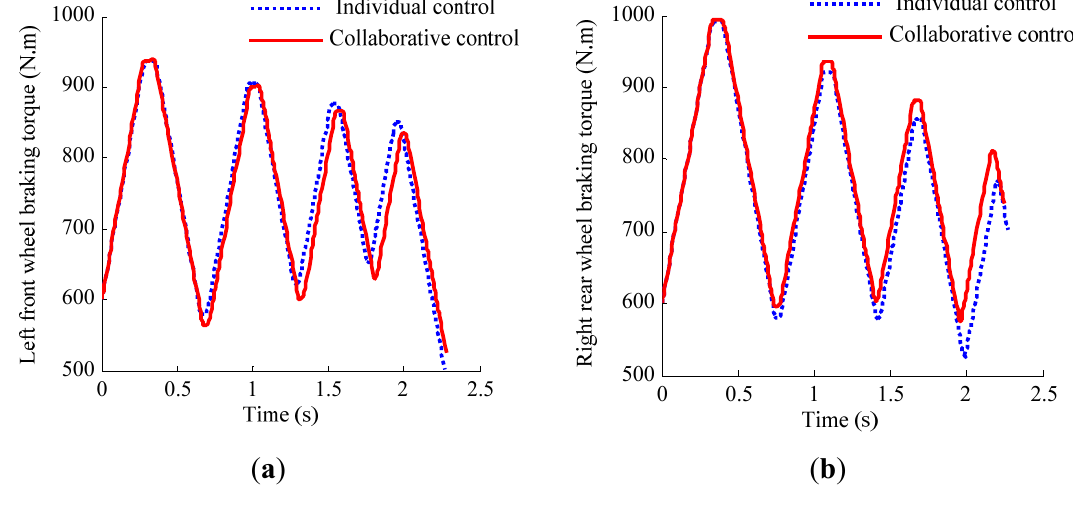
Figure 7. Simulation results of vehicle braking torques: ( a ) Left front wheel braking torque; ( b ) Right rear wheel braking